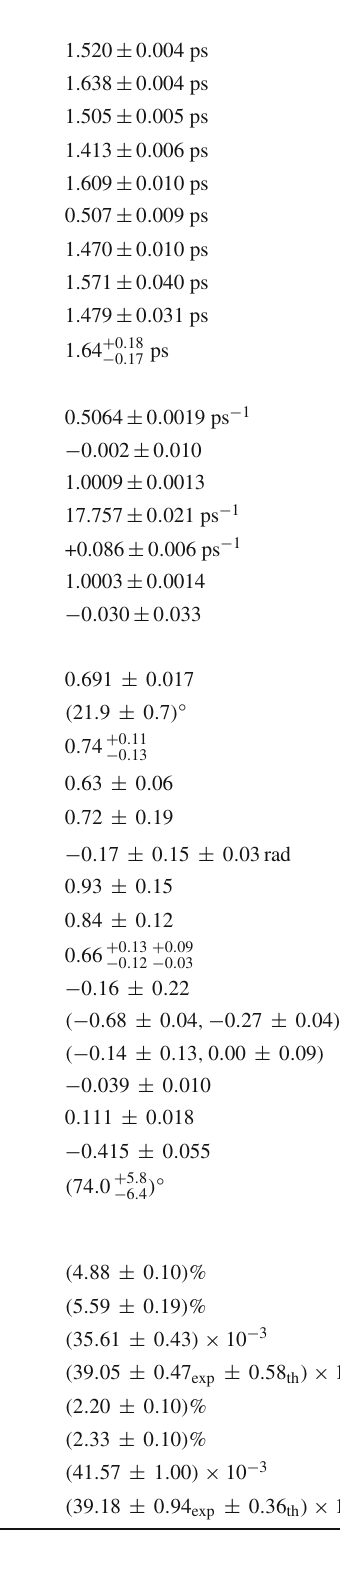
Table 320 Selected world averages. Where two uncertainties are given the first is statistical and the second is systematic, except where indicated otherwise b -hadron